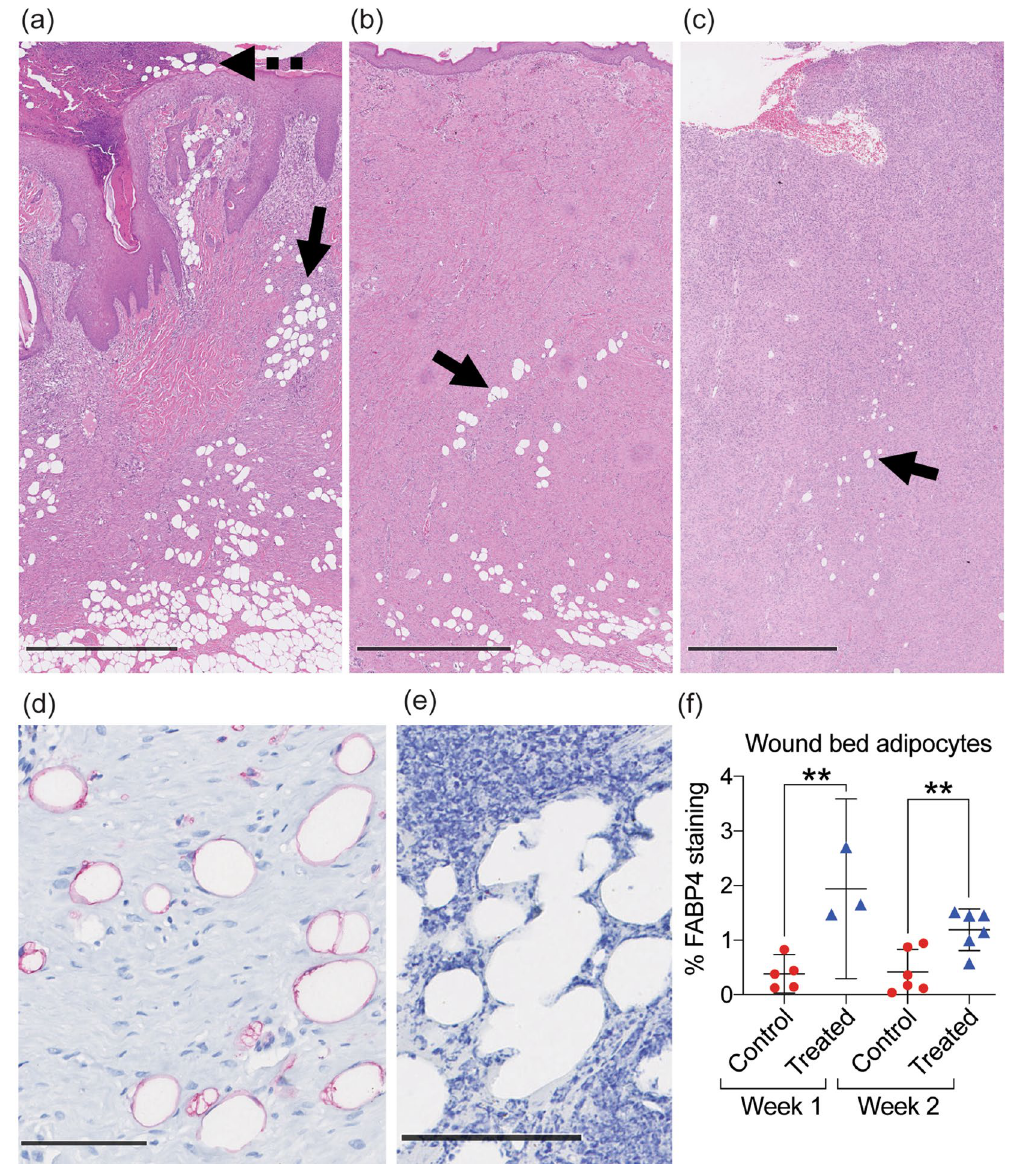
Figure 6. Presence of mature adipocytes in wound beds. ( a ) H&E staining of MSTC-treated wound at 1 week. Many adipocyte-like structures were seen within the wound bed (solid arrow) and outside the epidermal surface (dotted arrow). ( b ) MSTC-treated wound at 2 weeks, showing adipocyte-like structures still present in wound bed (arrow). ( c ) Fewer adipocyte-like structures were also present in some control wounds (arrow). ( a – c ) Scale bars = 1 mm. ( d ) IHC staining for the adipocyte marker FABP4 (red). ( e ) Adipocyte-like structures outside of the epidermal surface (dotted arrow in a ) did not retain FABP4 expression. ( d , e ) Scale bar = 100 μm. ( f ) MSTC- treated wounds had higher density of FABP4+ adipocytes than control wounds at both time points. **p ≤